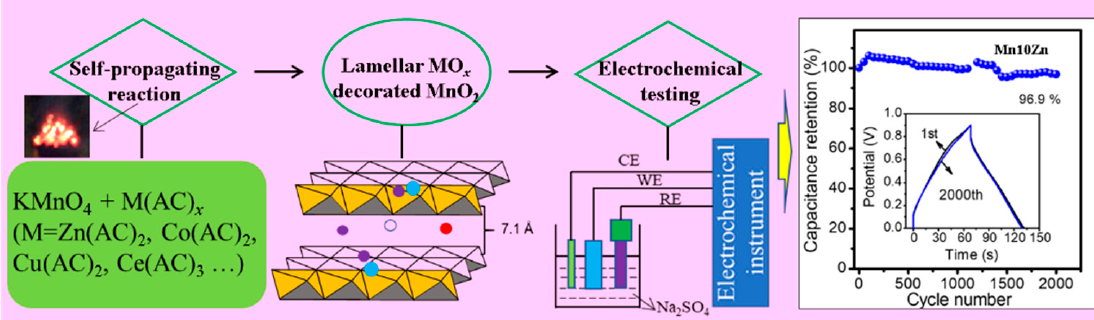
Figure 1. Schematic illustration of the self-propagating technology (SPT) strategy and electrochemical performance